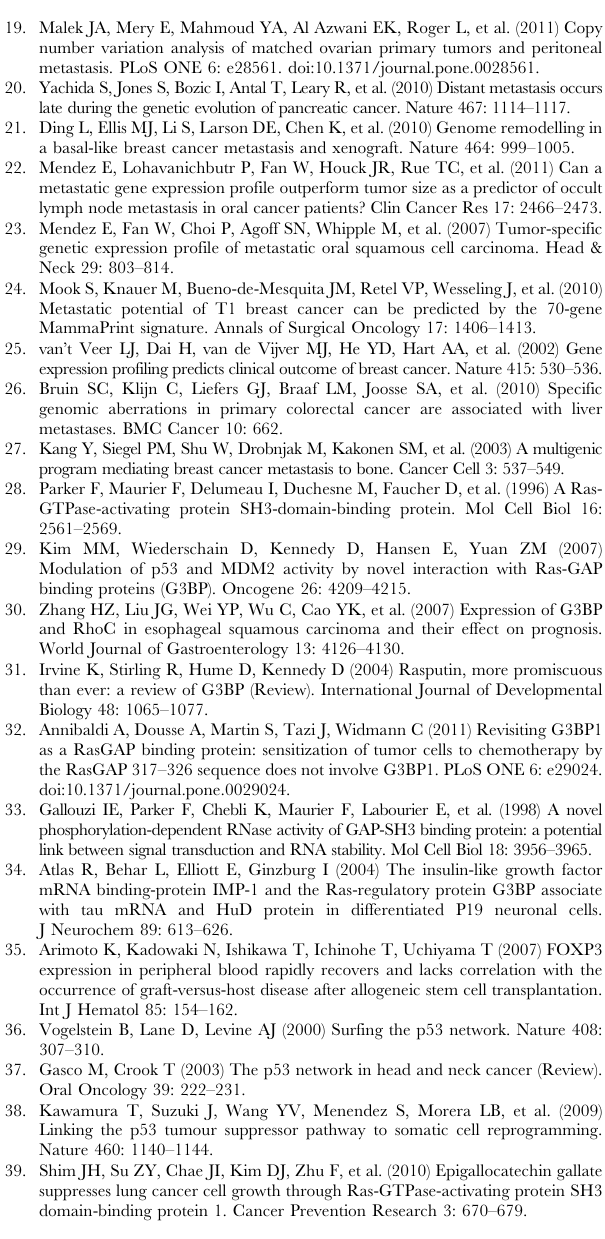
Table S1 Characteristics of patients with metastatic and non- metastatic OSCC. (XLSX) Table S2 Ingenuity Pathway Analysis top functional categories of the CNA-associated differentially expressed genes. (PPTX) Table S3 Characteristics of OSCC patients in cluster 1 and cluster 2. (XLSX) Table S4 Characteristics of the OSCC cell lines used for siRNA functional screens. (PPTX) Table S5 siRNA sequences used for gene knockdown. (XLSX)